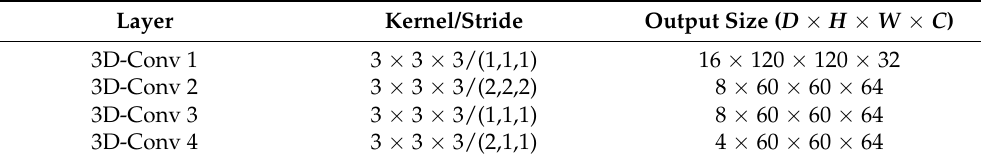
Table 2. Architecture of 3D-convolutional neural network (CNN) in encoder. Layer